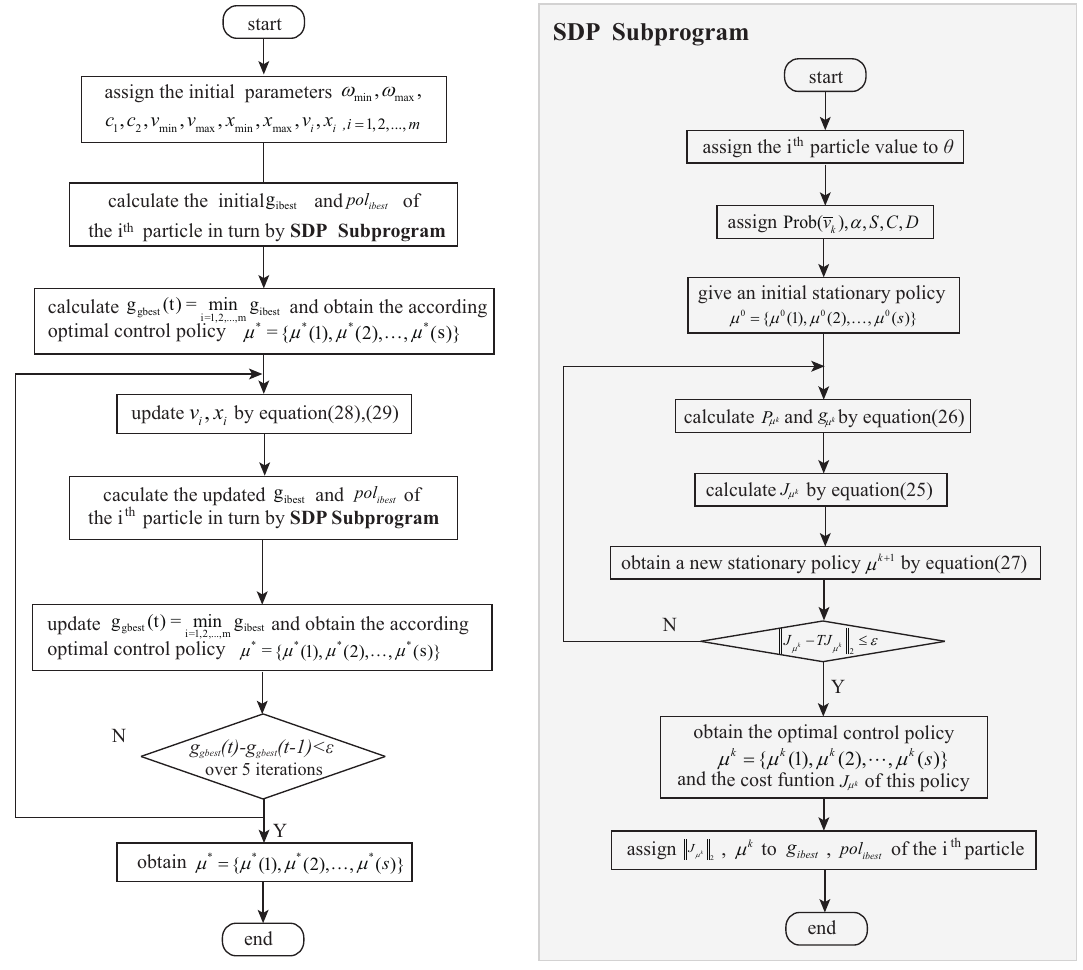
Figure 7. Flowchart of the